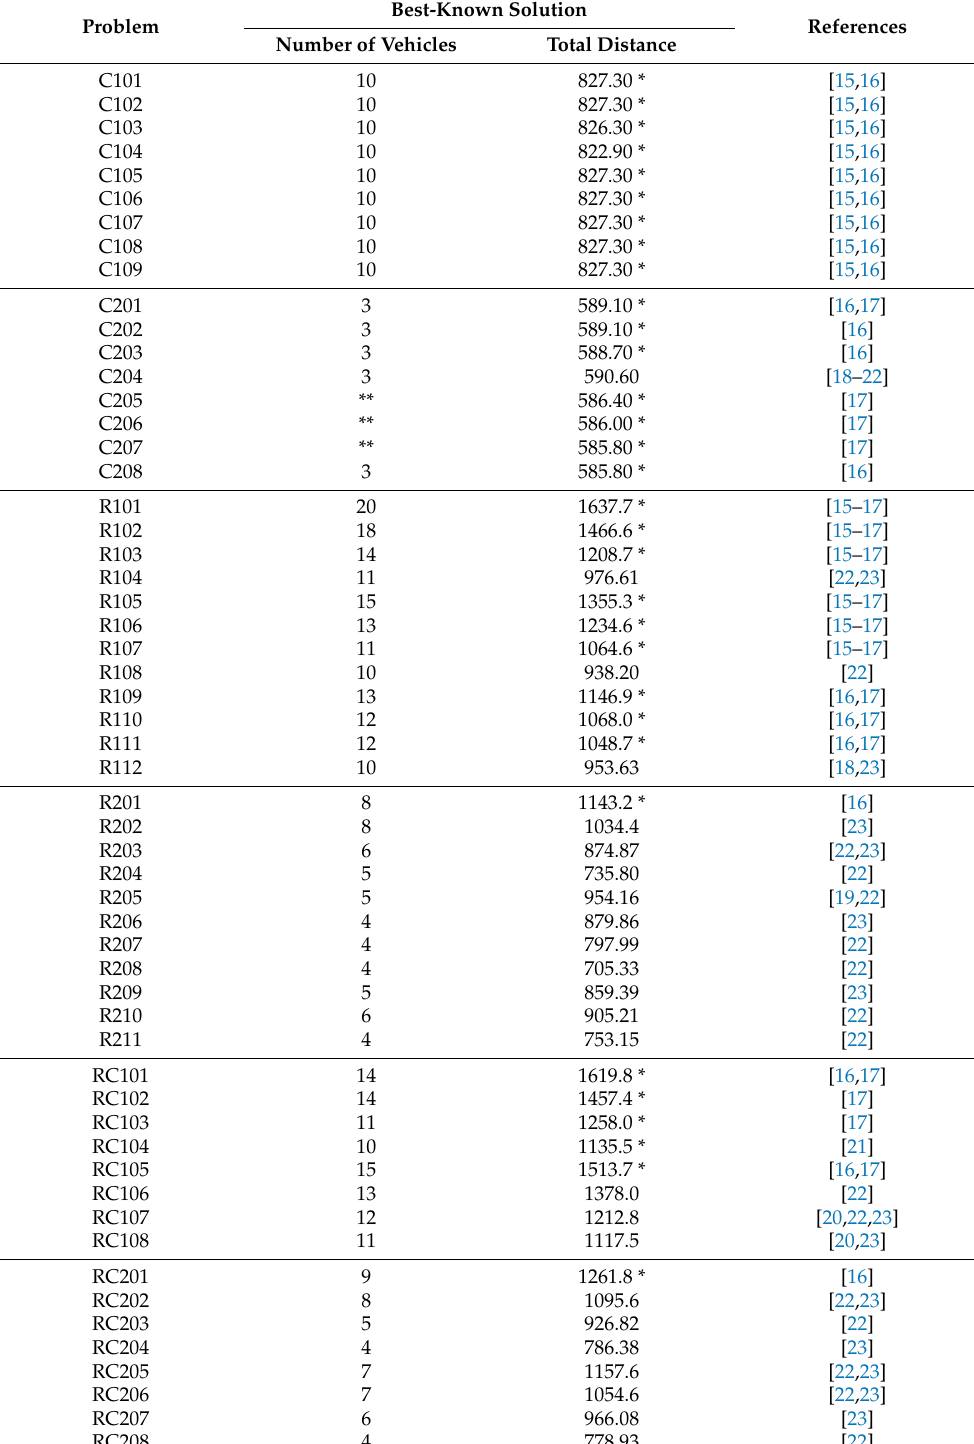
Table 1. The best objective function values obtained in literature on Solomon’s instances.